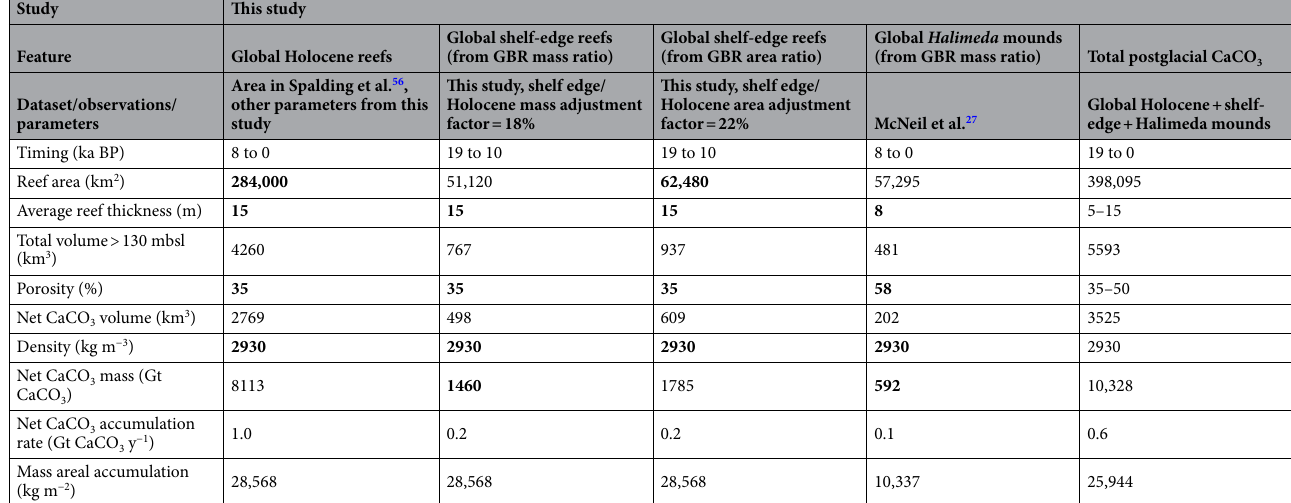
Table 3. Global estimates of shallow-water reefs, shelf edge reefs and Halimeda bioherms as extrapolated from the proportions of the different features relative to the Holocene reefs of the GBR. Bold highlight the parameters applied in each case from which the rest of the values were